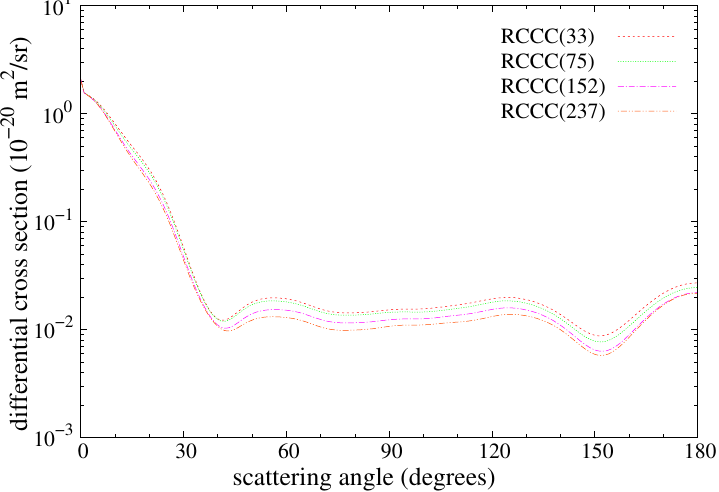
Figure 9. Convergence of the RCCC differential cross section with number of states. Only shown for the 5 p 2 3 P 0 5 p 2 3 P 2 fine-structure transition at 40 (cid:1)